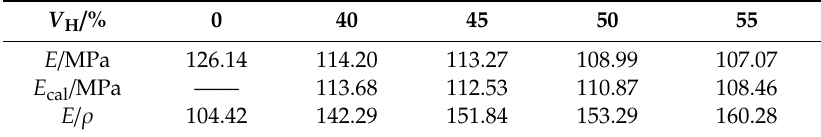
Table 5. The mechanical properties of composites with di ff erent volume fraction HGMs.